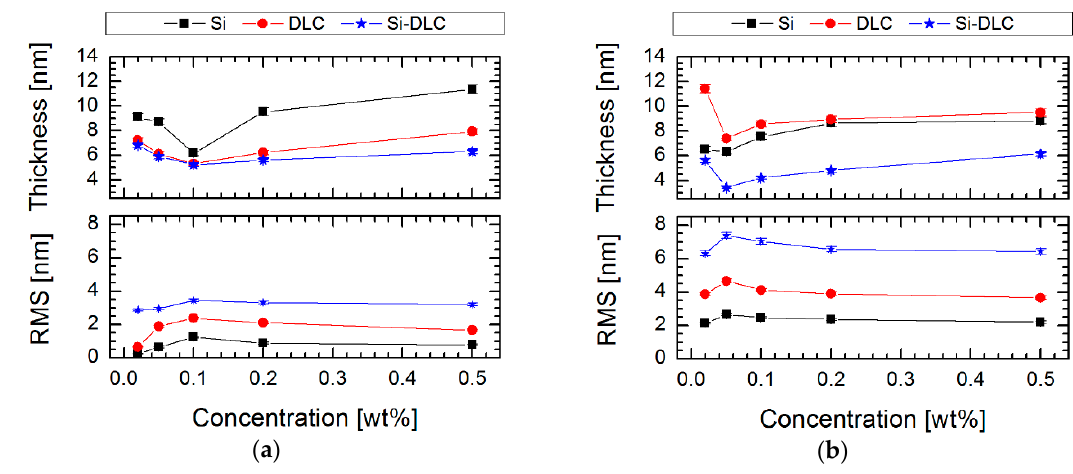
Figure 7. Effect of concentration solution of perfluoroalkylsilane on thickness and roughness (RMS) of SAMs created on three surfaces with different contents of silicon for modifiers: ( a ) FPTS and ( b ) FDTS.